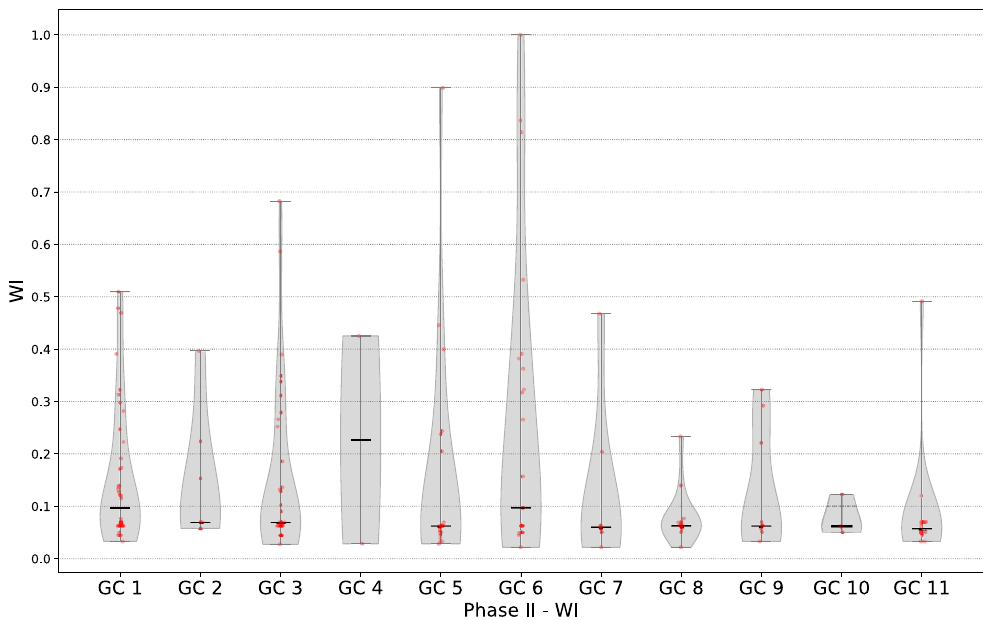
Figure 7: WI distribution of Dunaújváros Phase II ( c. 1950 – 1650 BCE ) by GC. Bold black bars indicate the median.